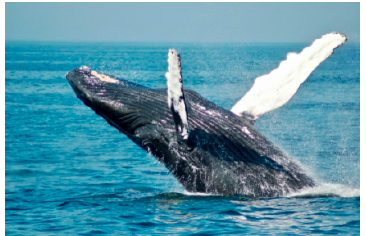
Figure 1. Humpback whale flippers with tubercles.